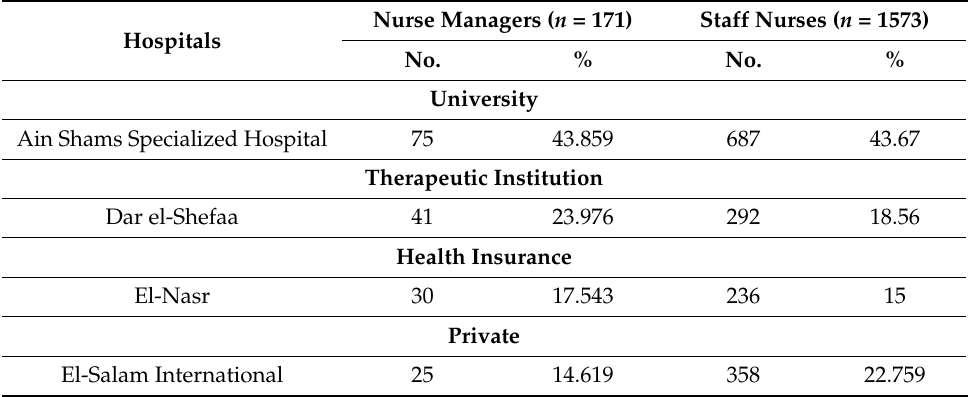
Table 1. Distribution of study subjects according to